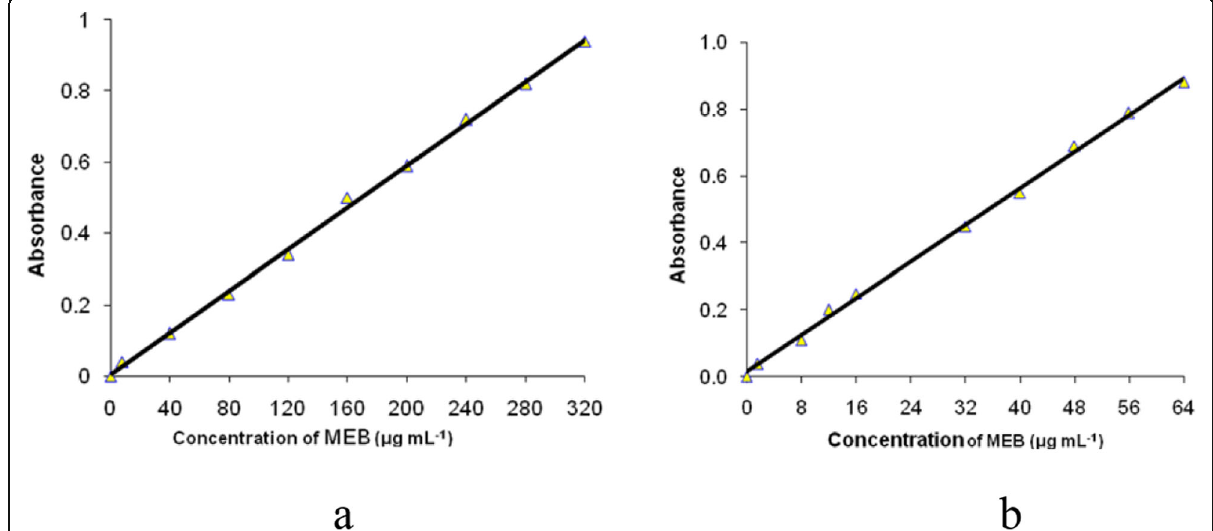
Fig. 5 Calibration curves for a. PCA method and b. DDQ